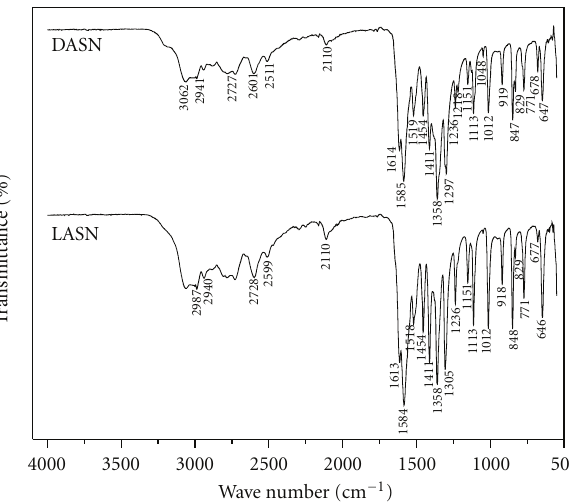
Figure 3: FTIR spectrum of LASN and